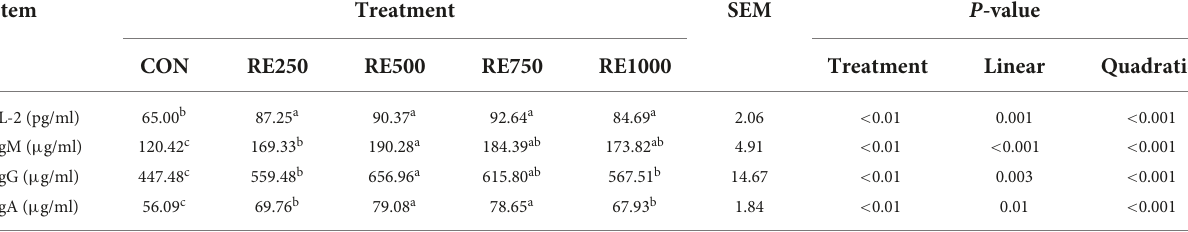
TABLE 6 Effects of rosemary extract on serum immunological parameters of broilers 1